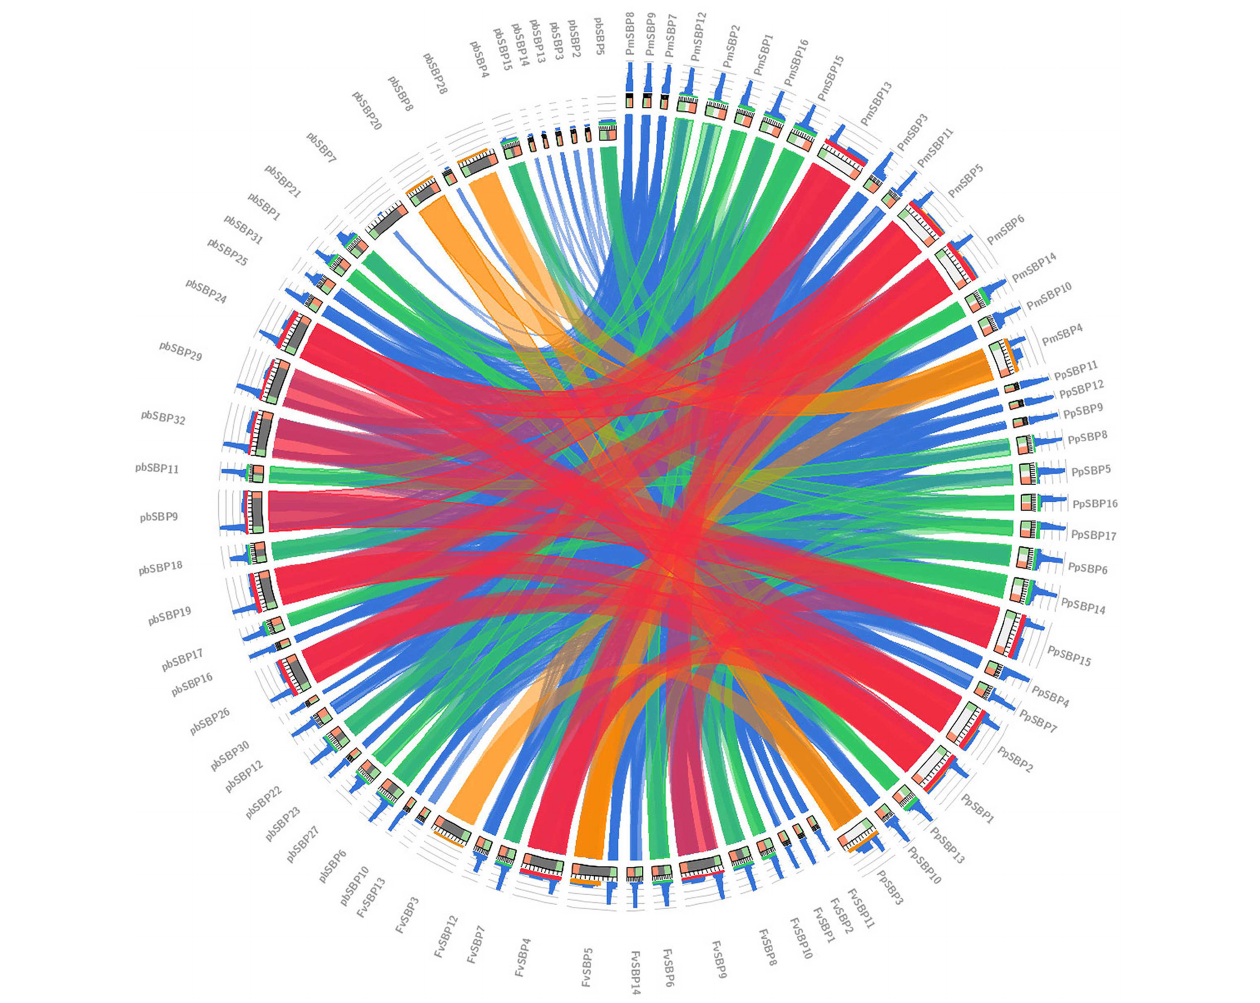
FIGURE 6 | Eighty SBP-box genes collinearity analysis. Colored lines which connect two regions indicate collinearity regions between Strawberry, Pear, Mei, and